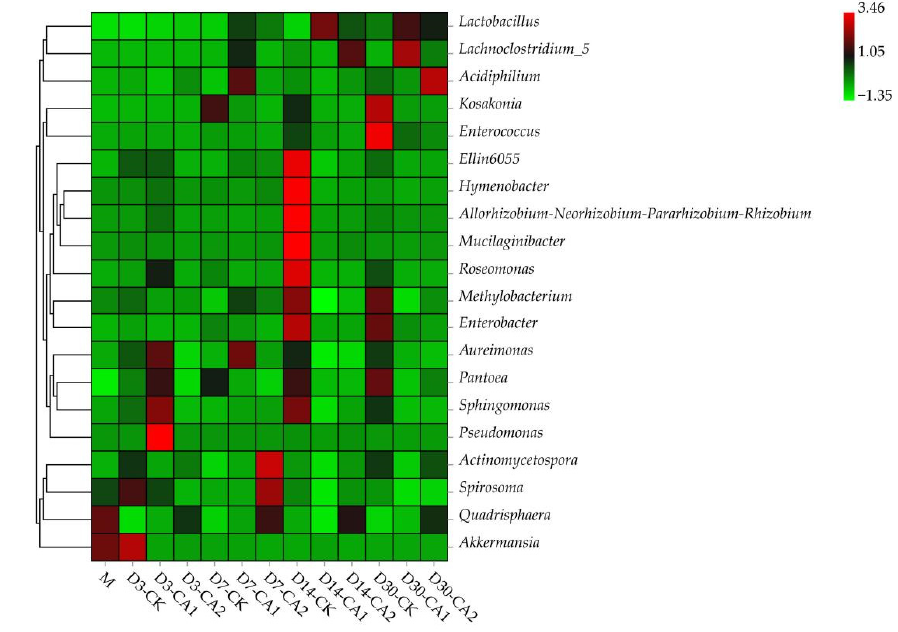
Figure 4. Bacterial community and relative abundance by genus for mulberry leaf silages (M, pre- ensiled material; CK, the control; CA1, 1% citric acid; CA2, 2% citric acid; D3, 3 days of ensiling; D7, 7 days of ensiling; D14, 14 days of ensiling; D30, 30 days of ensiling).